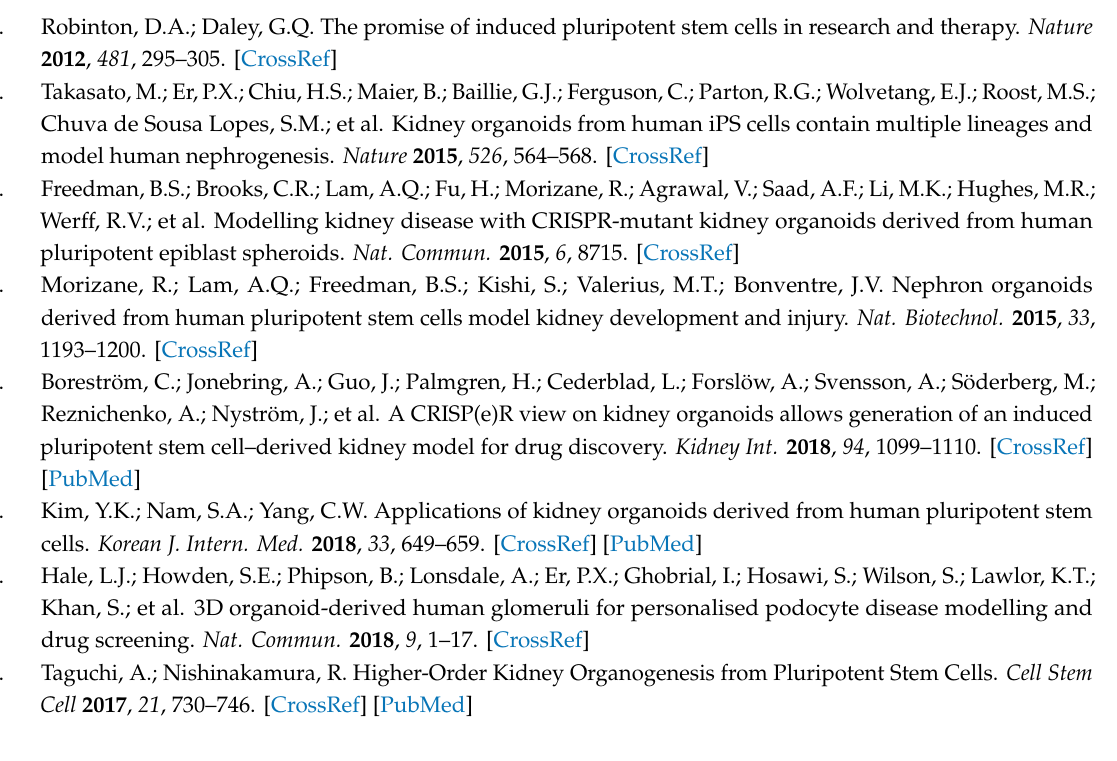
Table S1: Primers (5 (cid:48) -3 (cid:48) ) used in the study. Table S2: Summary of available protocols of di ff erentiation of mouse and human PSC to UB linages. Figure S1: Di ff erentiations of mESC into ureteric bud progenitor cells. Figure S2: Di ff erentiated mESC induce embryonic MM to nephrogenesis. Figure S3: Vascularization of the kidney organoids. Figure S4: Characterization of kidney organoids. Figure S5: Kidney organoids model kidney development and